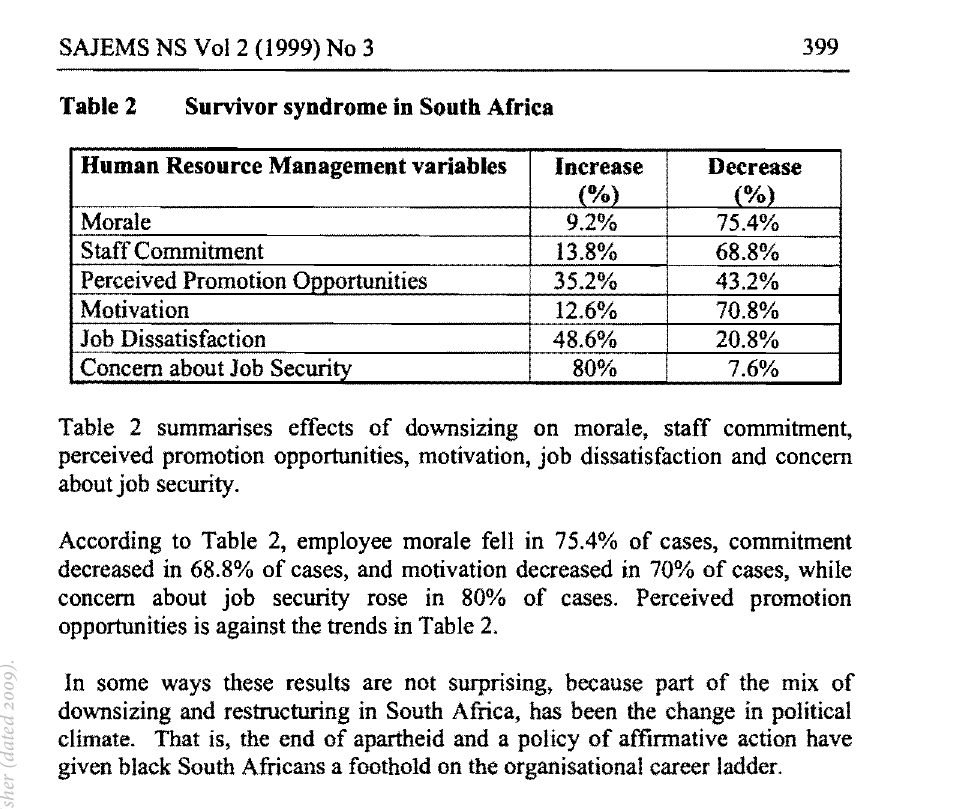
Table 2 summarises effects of downsizing on morale, staff